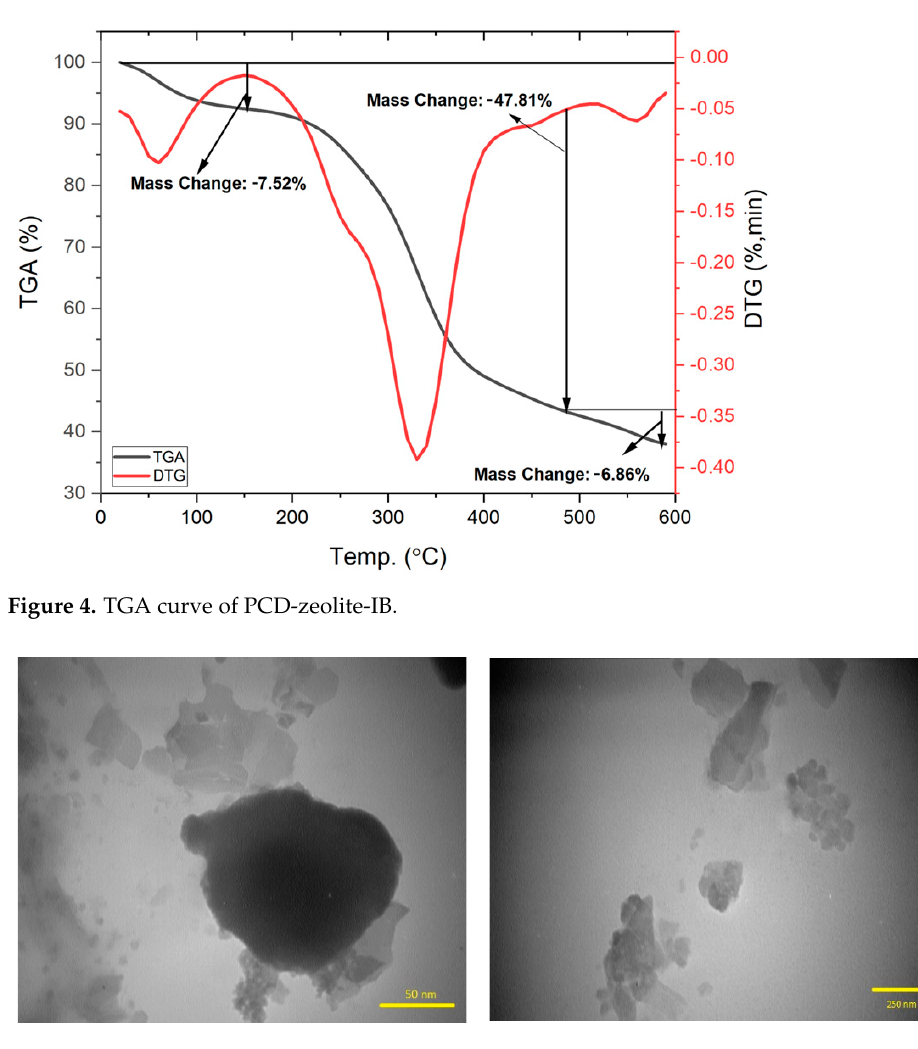
Figure 5. TEM image of PCD-zeolite-IB.